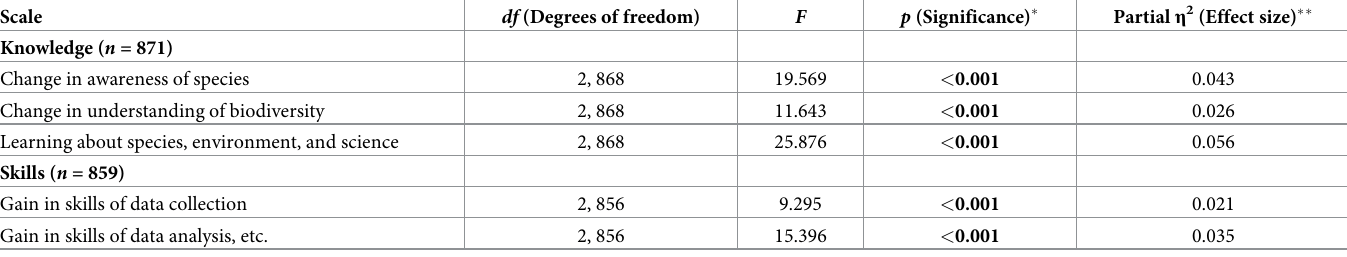
Table 5. Results of the one-way independent ANOVA test for the amount of information about threats to species that was received by the project participants.